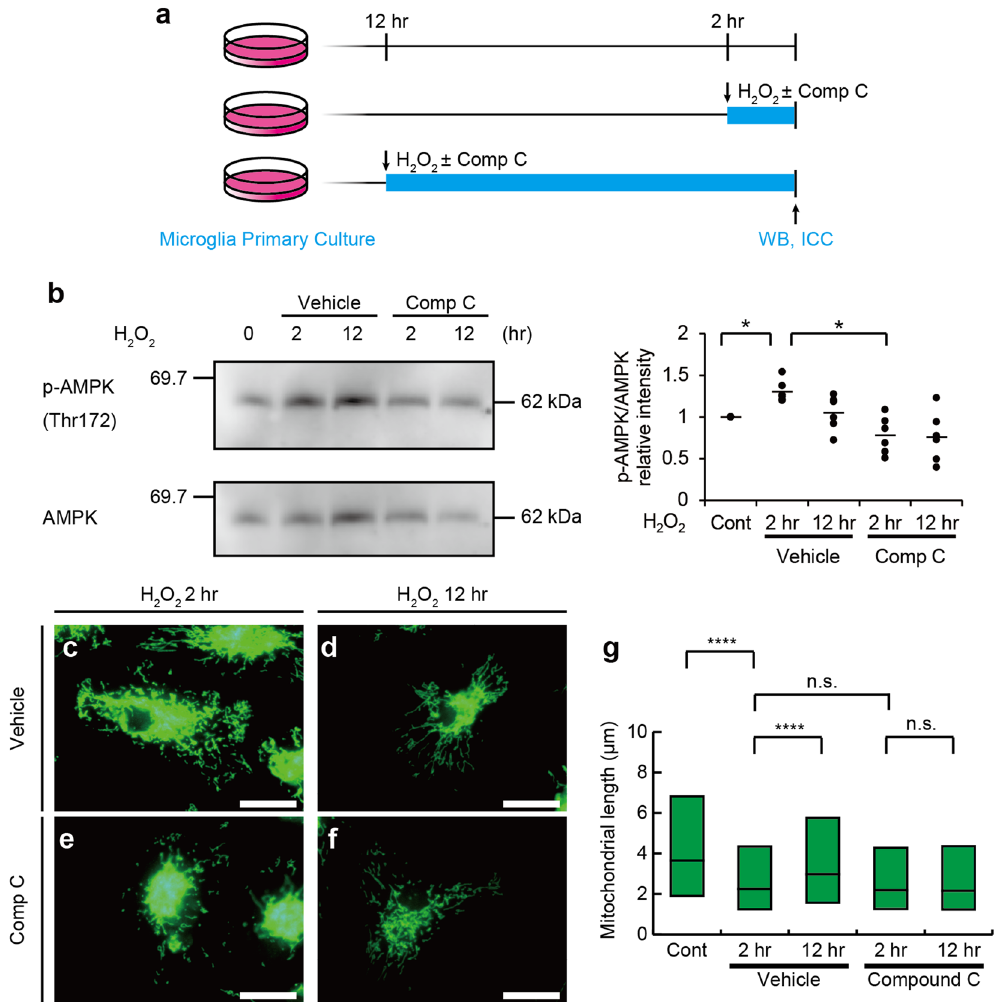
Figure 7. ROS activates 5 ′ adenosine monophosphate-activated protein kinase (AMPK) to facilitate mitochondrial elongation. ( a ) Primary microglial cultures were treated for 2 or 12 hr with or without hydrogen peroxide (H 2 O 2 ) and the selective AMPK inhibitor, Compound C (Comp C), and then subjected to Western blotting (WB) and immunostaining (ICC). Western blotting of AMPK phosphorylated at Thr172 (p-AMPK) with treatments of H 2 O 2 and Comp C ( b , left), and quantification of the Western blotting analyses ( b , right) are shown. * p < 0.05 in the t-test (N = 6). Each dot represents each replicate and means (bars) are shown. Representative images ( c–f ) and the measured lengths ( g ) of TOM20-immunopositive mitochondrial profiles with treatments of H 2 O 2 and Comp C. N = 1975 (control), 4536 (H 2 O 2 2 hr), 3156 (H 2 O 2 12 hr), 3486 (H 2 O 2 2 hr + Comp C), and 2966 (H 2 O 2 12hr + Comp C) for mitochondria. n.s.: not significant and **** p < 0.0001 in the U -test. Medians ( g , bars) with quartile ranges ( g , boxes) are shown. Bars: 20 μ